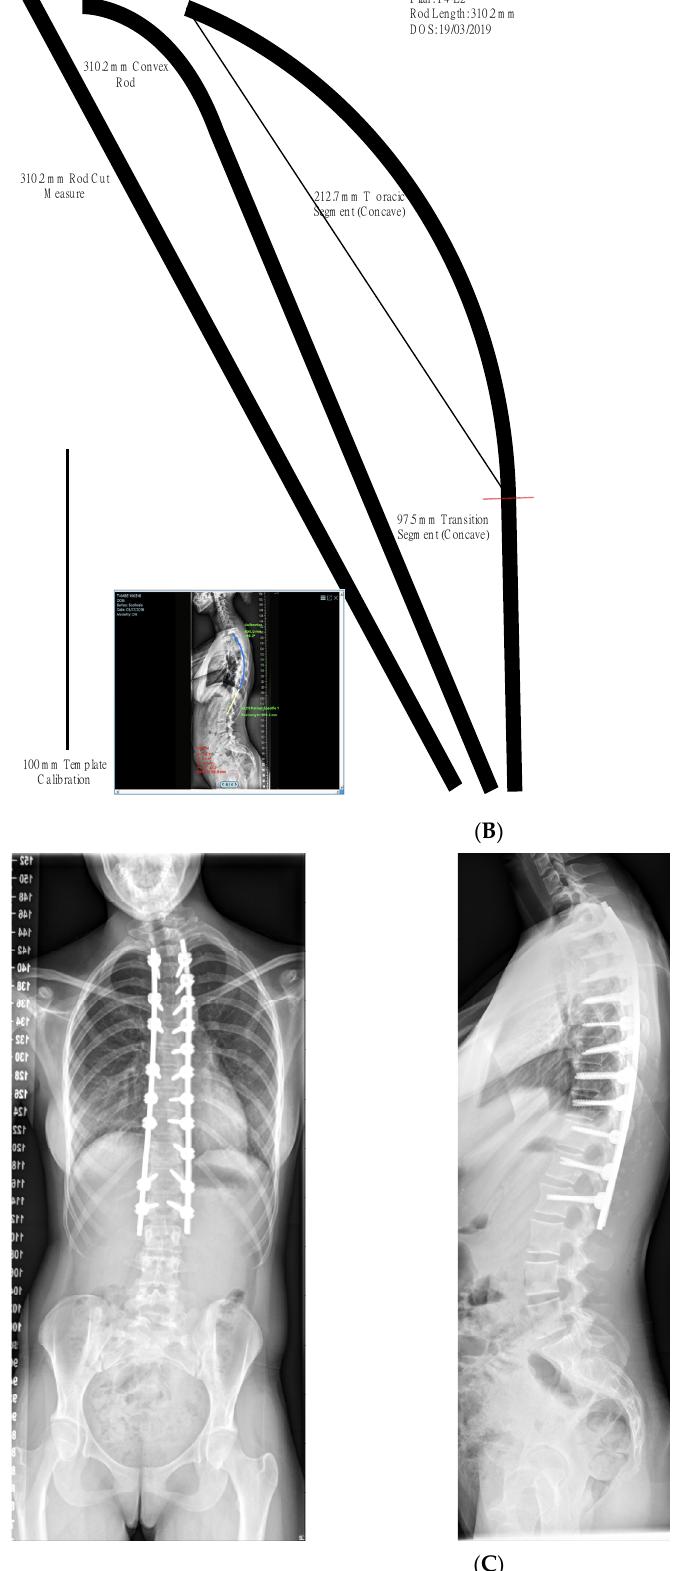
Figure 5. ( A ) Pre-op X-ray AIS F: 15 yrs. Pre-op TK 33, MT Cobb: 61.5. Predicted TK: 34. ( B ) Patient- specific rod template. ( C ) Post-op X-ray at 6 months. Post-op: TK: 38.6: MT: 1.5.